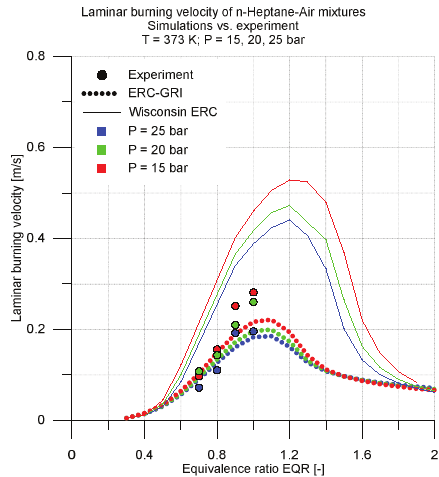
Fig. 5. Validation of LBVs for n-heptane/air mixtures